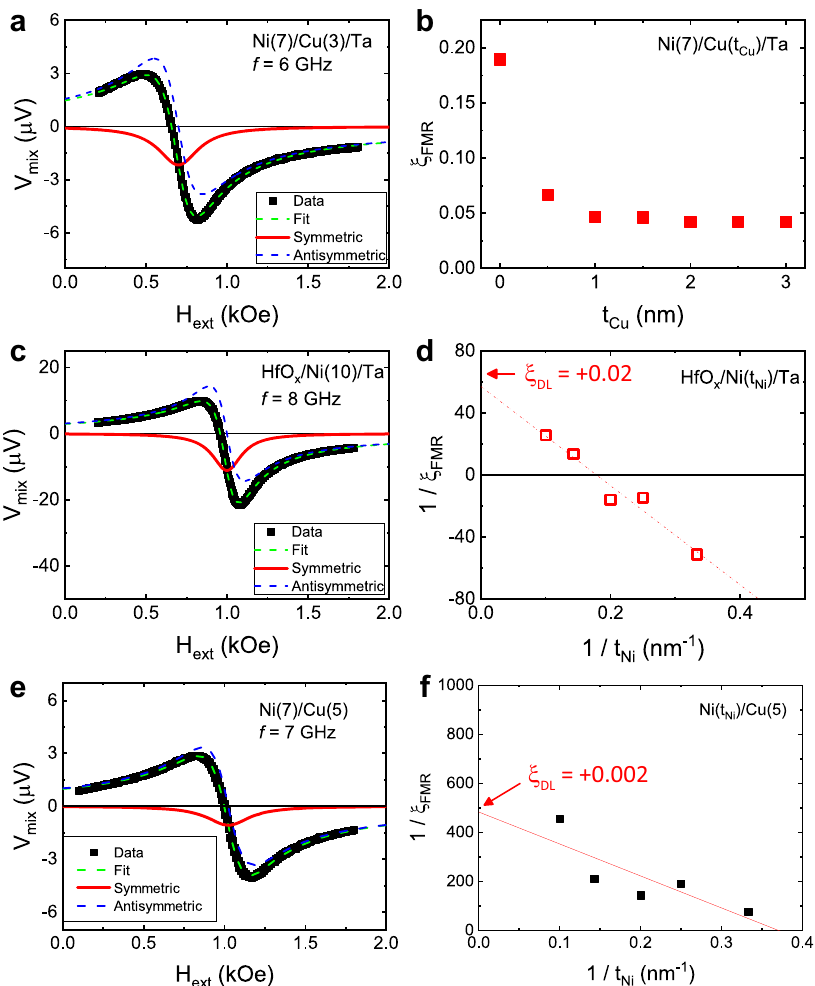
Fig. 4 Control experiments for other possible mechanisms. a ST-FMR spectra of a Ni(7)/Cu(3)/Ta sample. b ξ FMR as a function of the Cu-layer thickness t t Cu for Ni(7)/Cu( Cu )/Ta samples. c ST-FMR spectra of a HfO x (3)/Ni(10)/Ta sample. d 1